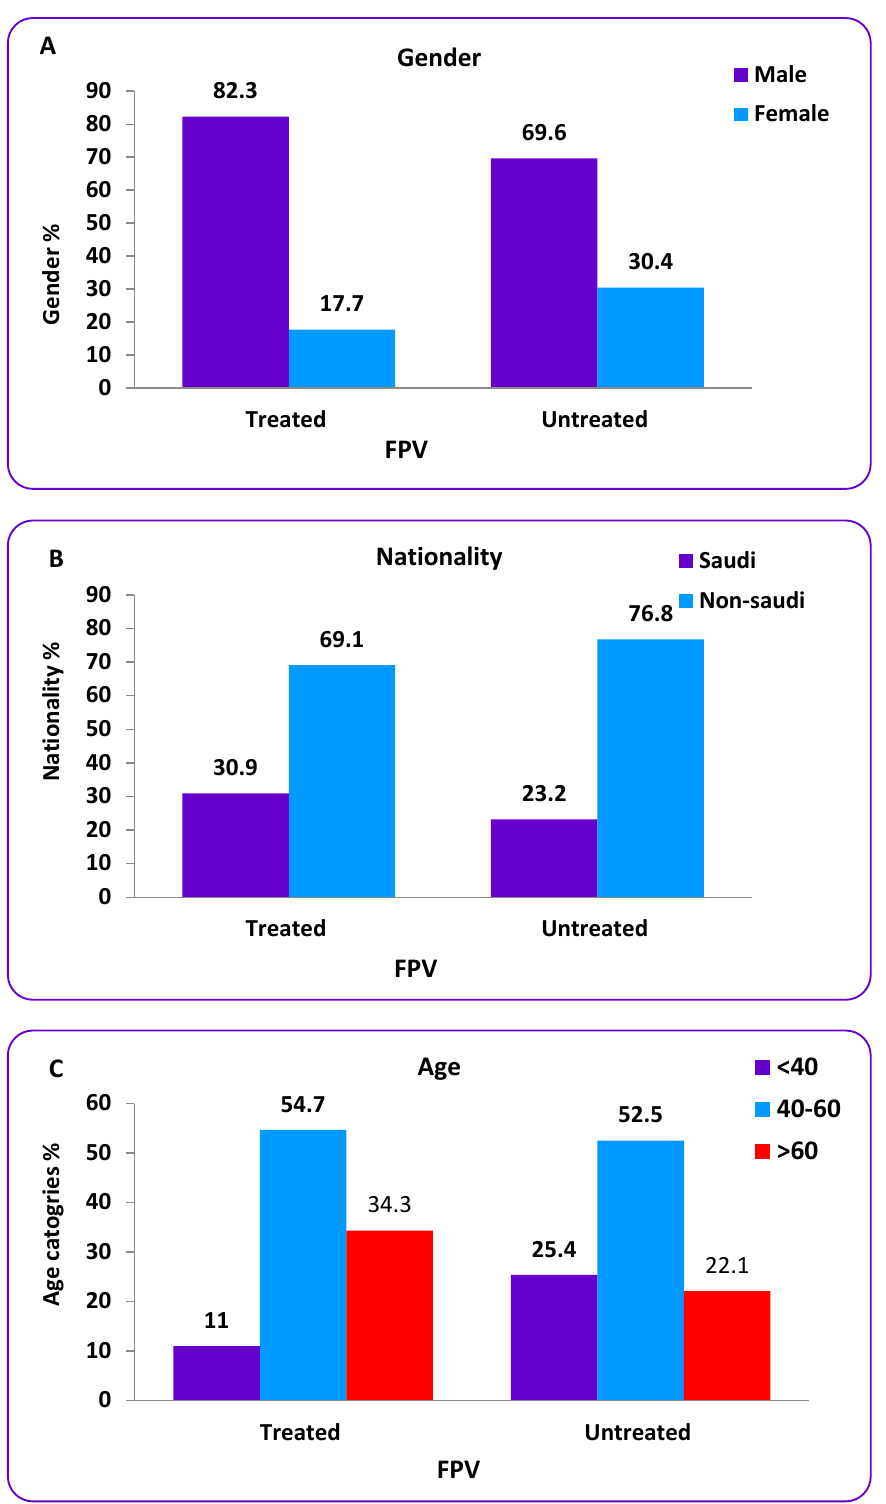
Figure 3. Frequency ratio of males and females ( A ), nationalities ( B ), and ages ( C ) in treated and untreated patients with FPV.